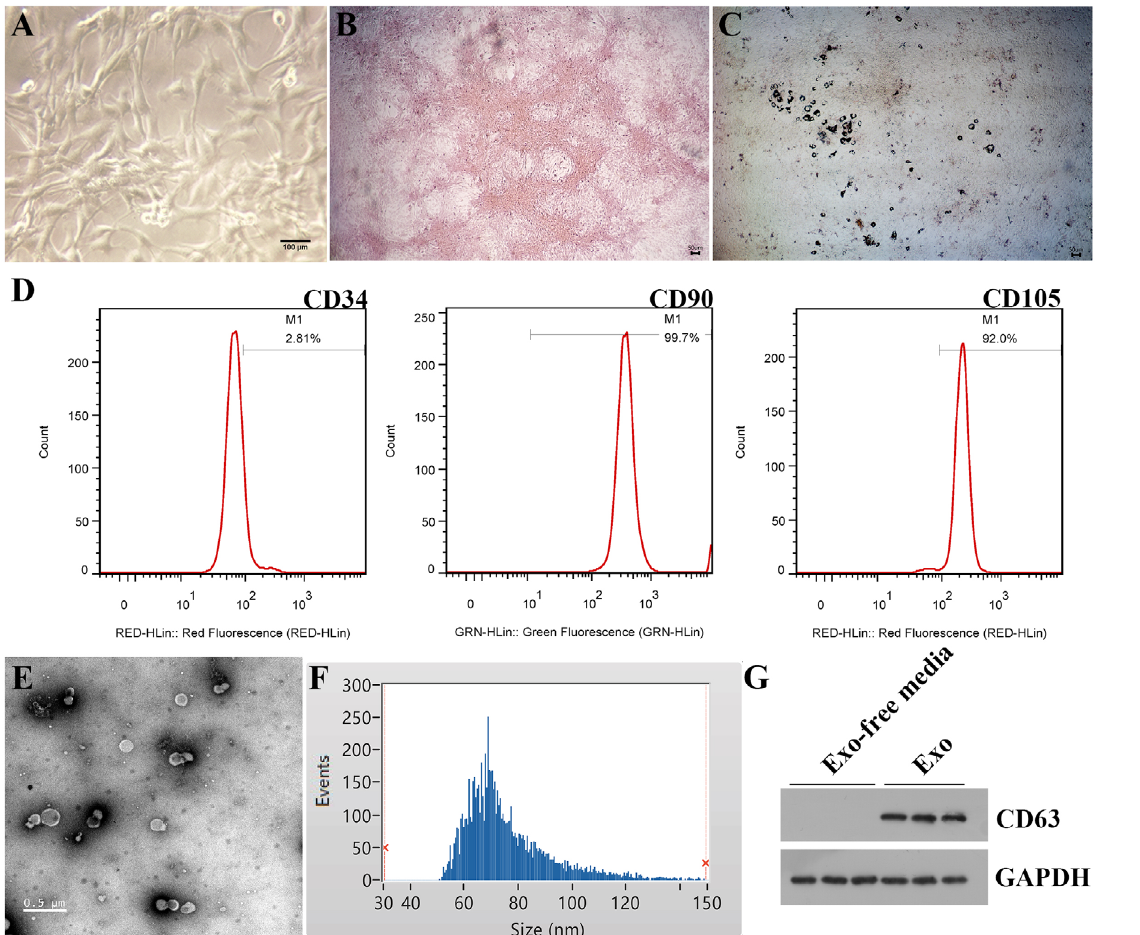
Figure 1 – Characterization of mesenchymal stem cells (MSCs) and MSCs-exosomes. A. Morphological observation of MSCs. Scale bar = 100 μm. B. Alizarin red staining of MSCs. Scale bar = 50 μm. C. Oil red O staining of MSCs. Scale bar = 50 μm. D. The surface antibodies (CD34, CD90, and CD105) of MSCs were detected by flow cytometry. E. Morphology of MSCs-exosomes was observed by transmission electron microscopy. Scale bar = 0.5 μm. F. Particle size distribution of MSCs-exosomes was measured by nanoparticle tracking analysis. G. Western blot analysis of the exosomes surface marker